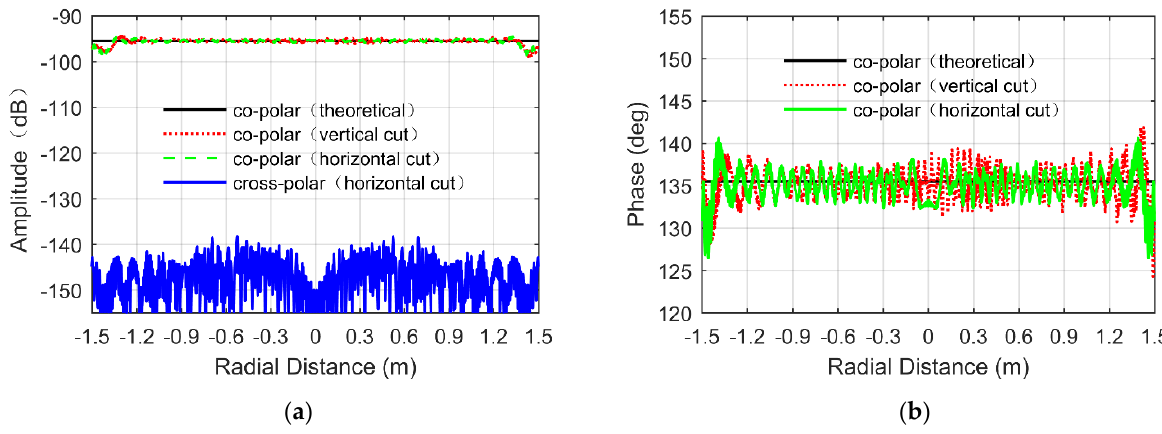
Figure 7. PO + PTD one-dimensional simulated results of the designed tri-reflector CATR with standard quadric surfaces when illuminated by a shaped feed at 500 GHz. ( a ) Co- and cross-polar amplitude; ( b ) co-polar phase. Table 2. Quiet zone performance of the designed tri-reflector compact antenna test range (CATR) on principal cuts (quiet zone diameter 2.25